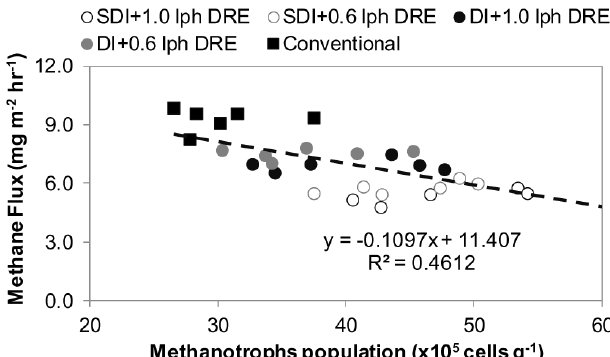
Figure 5. Methane emission as a function of methanotroph population under drip and conventional treatments during flowering. The black line shows a regression line (y=-0.1097x+11.407). The r 2 is the coefficient of determination. SDI, sub-surface drip irrigation; DI, surface drip irrigation; DRE, discharge rate emitters; Conventional, conventional flood aerobic